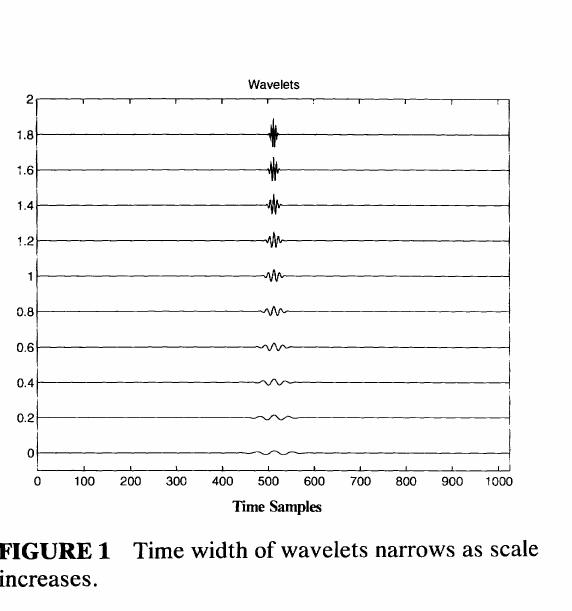
FIGURE 1 Time width of wavelets narrows as scale increases.